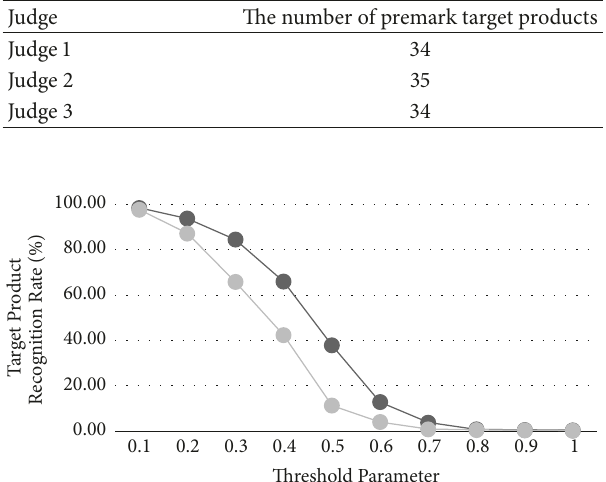
Table 6: Artificial premark results for the target product.